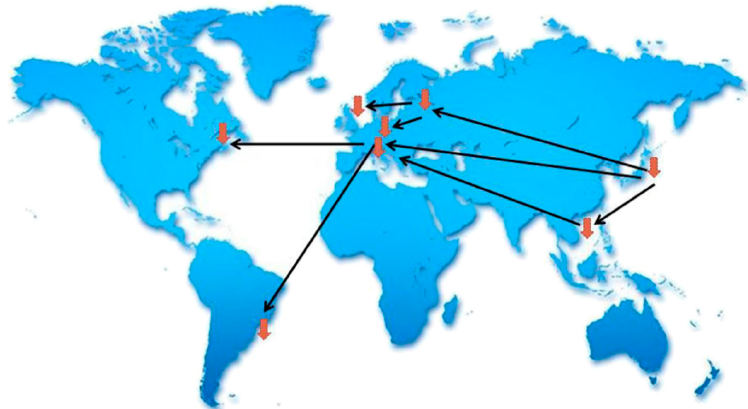
Figure 6. A price-quake. One of the main advantages of the nonlinearity in the integrate-and-fire oscillator model is that it enables a clear-cut identification of cause and effect. The figure shows one example of a price-quake, following an initial minus 7% price movement on the Japanese stock market on 23 May 2013. The figure is taken from (Liu et al. 2017).